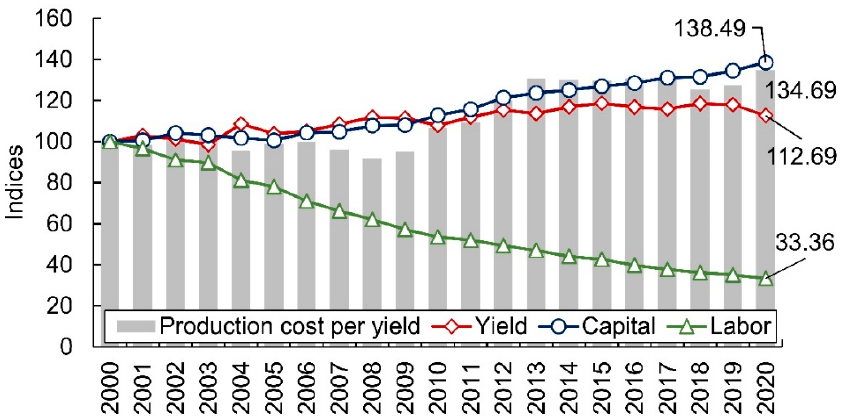
Figure 1. Change in indices of yield, capital input, labor input, and production cost per yield in rice production in China, 2000–2020. Data from the State Development Planning Commission of China [24], and National Development and Reform Commission of China [25].